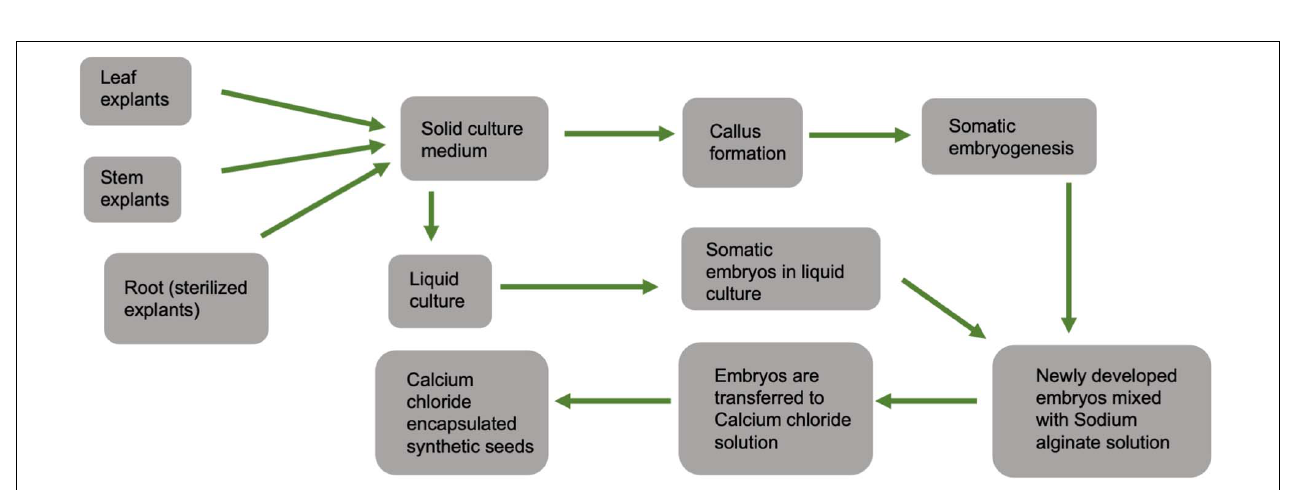
FIGURE 6 | General schematic diagram showing steps for calcium chloride encapsulated synthetic seed